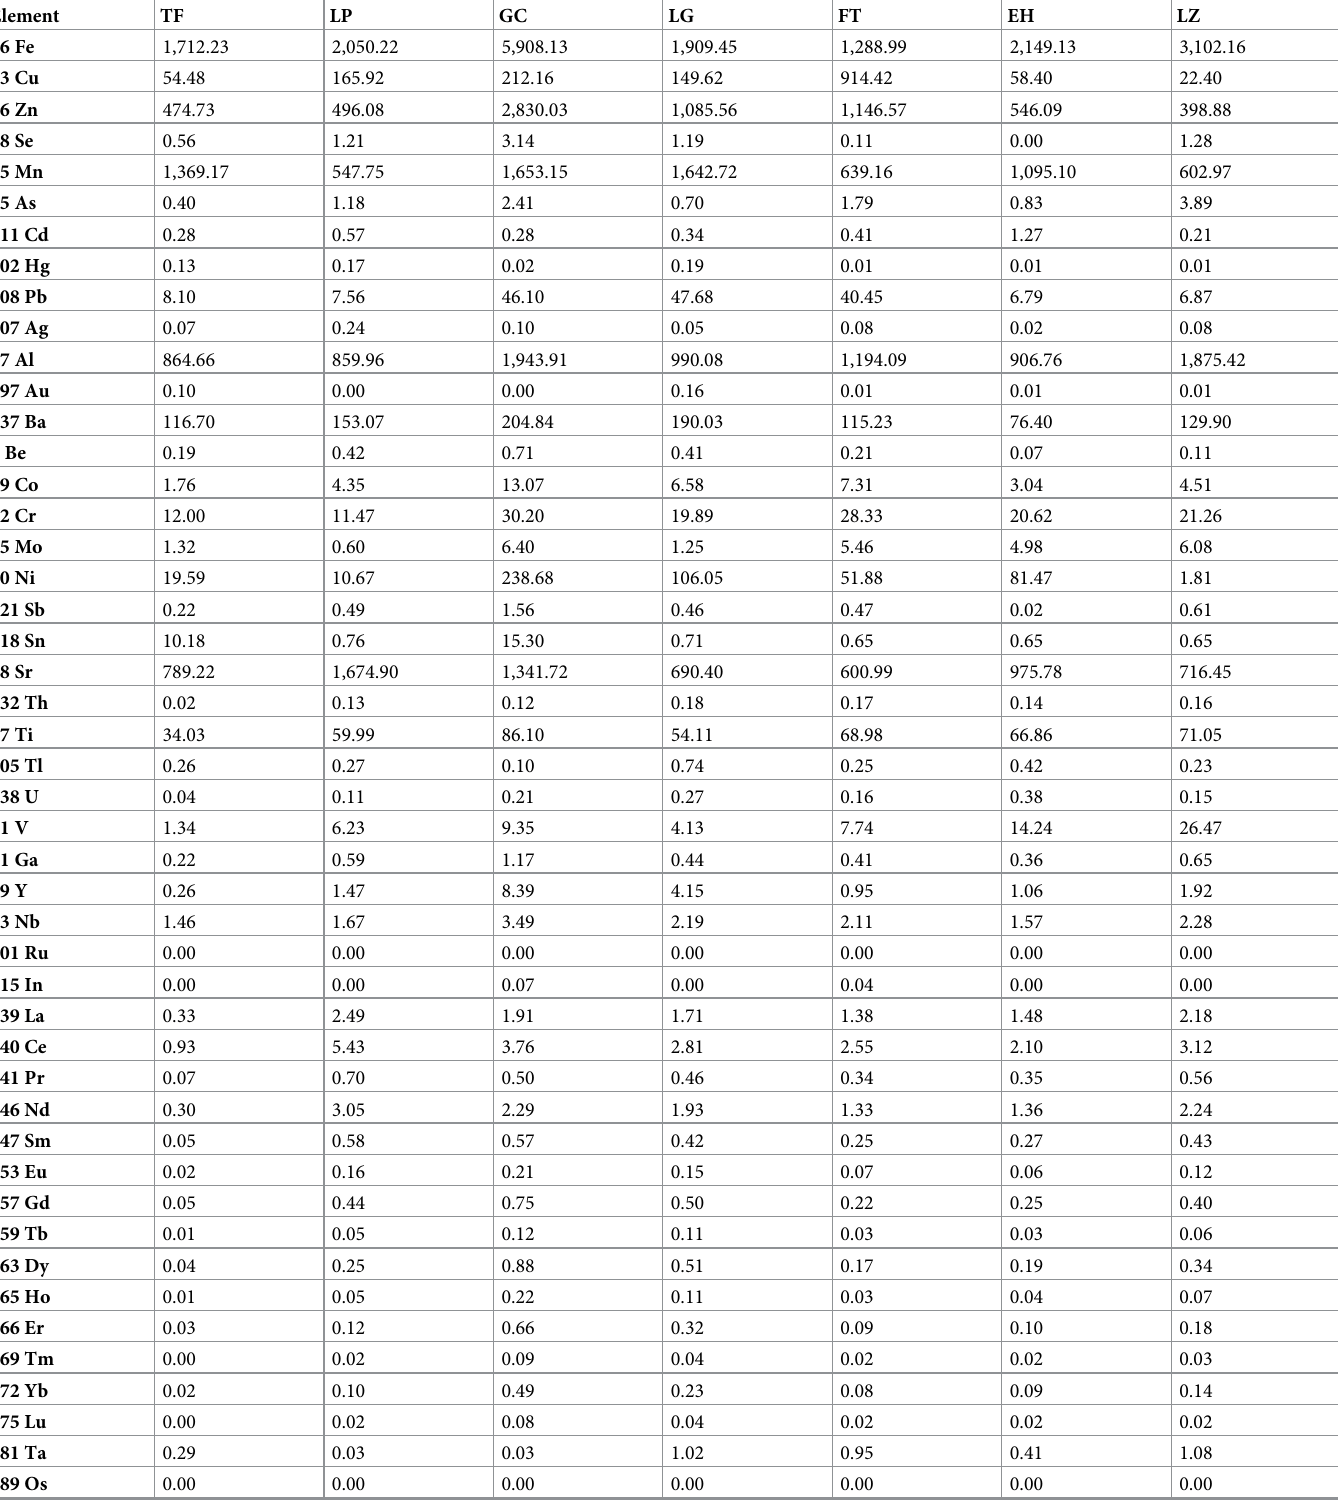
Table 3. Concentration of each element in ng/l, averaging the data for the two samples analysed per island.